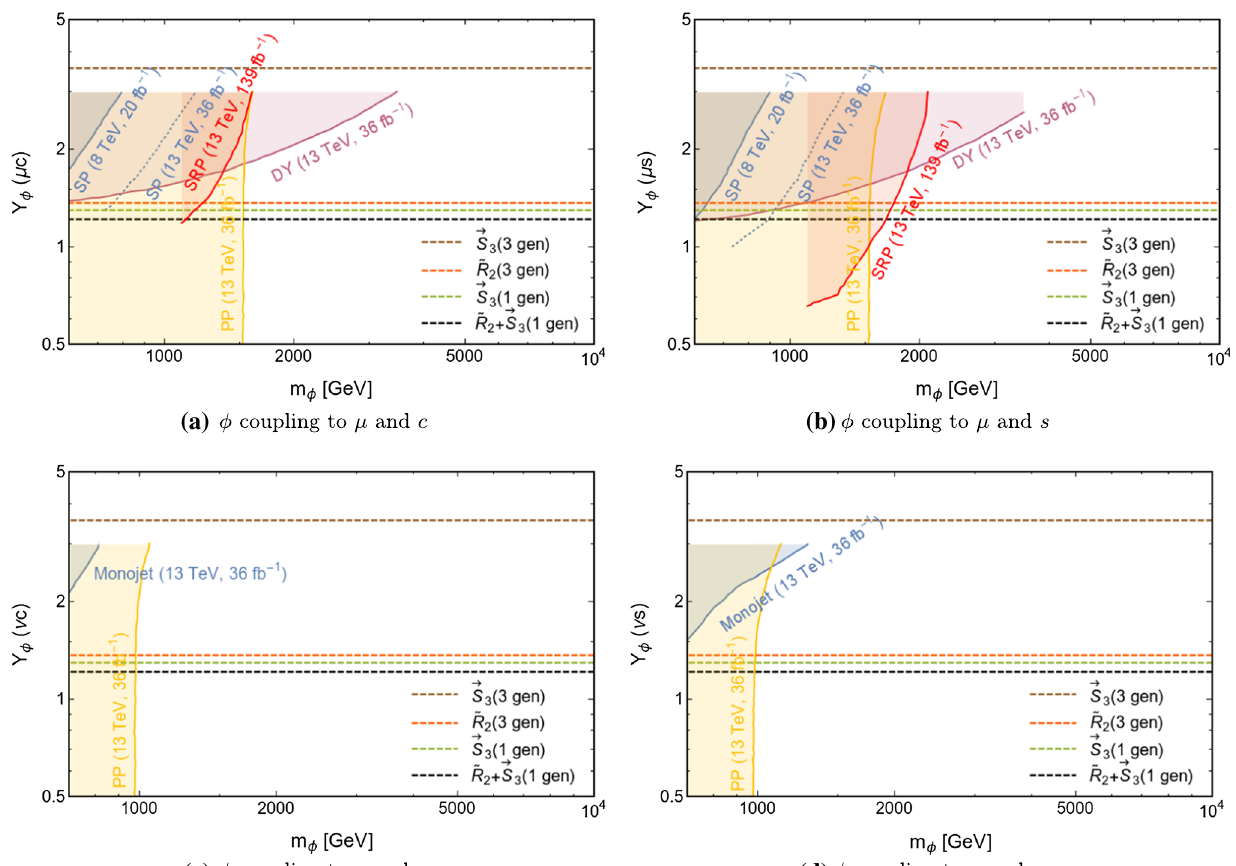
Fig. 20 Bounds on parameter space of scalar leptoquark coupling to second generation of quarks and leptons [156,157]. The shaded regions are disallowed by direct detection. The limits from pair production involving charged leptons are recast from [162], while the same involv- ing neutrinos are recast from [90]. These bounds are shown in yellow. The limits emerging from single production (SP), Drell–Yan (DY) and